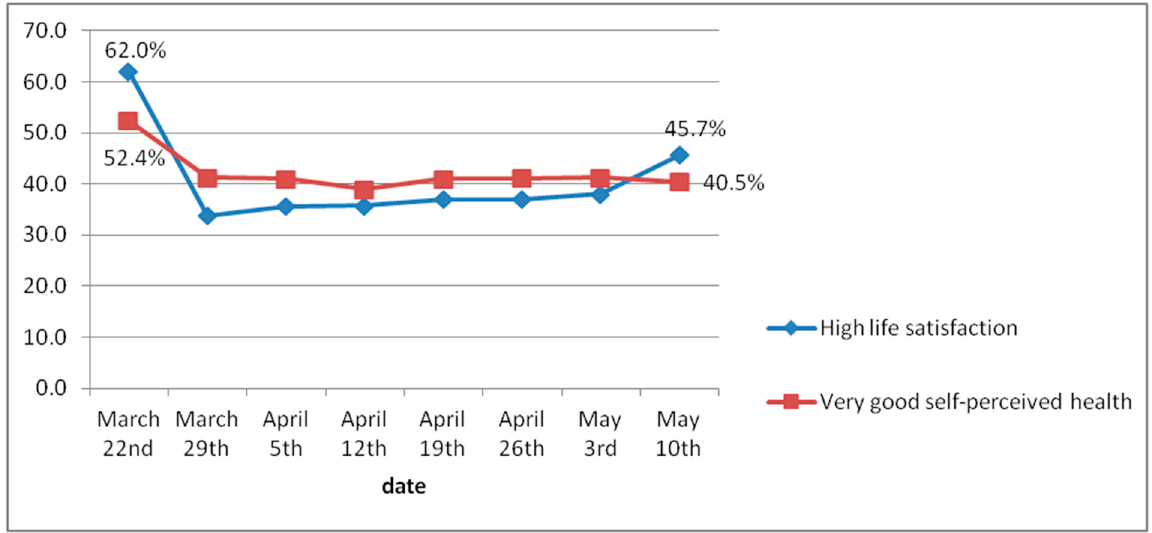
Figure 3. Global evolution of life satisfaction and self-perceived health. Participants seem to have been more optimistic about their personal futures (with a mean value of 3.1 out of 5) than the future of society in general (with a mean of 2.4 out of 5). A total of 33.4% of the respondents claimed to be optimistic or very optimistic about their personal futures, while only 10.9% felt the same levels of optimism about the future of society. Women were significantly less optimistic than men, both in terms of personal futures (20.7% vs. 42.3%) and the future of society in general (9.0% vs. 17.5%). Individuals under 35 years of age were the least optimistic about their futures. There were no statistical differences by age regarding optimism about the future of society.